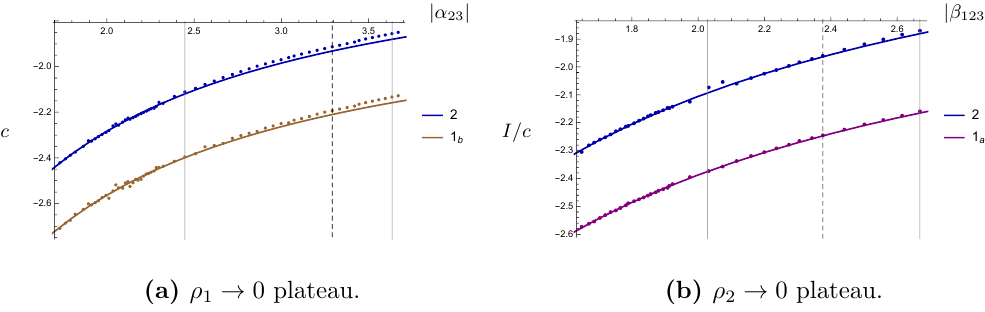
Figure 17 . A study of the pinching limits along the plateau in (cid:12)gure 16b comparing I=c for the indicated phases (dots) to the form (cid:0) A (cid:25) 2 function for best-(cid:12)t values of A; k . Vertical lines indicate ^ (cid:26) and the boundaries of (cid:12)gure 16.